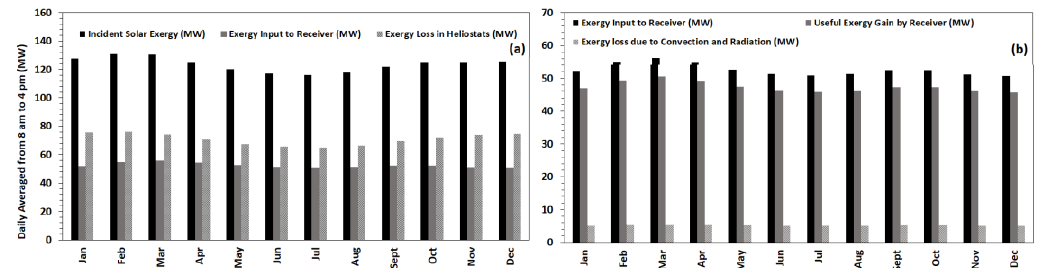
Figure 9. ( a ) Incident solar exergy, exergy collected at the central receiver and exergy loss in the heliostat field during 8 a.m. to 4 p.m. ( b ) Useful exergy gain by the receiver and exergy loss from the receiver due to natural convection and radiation.